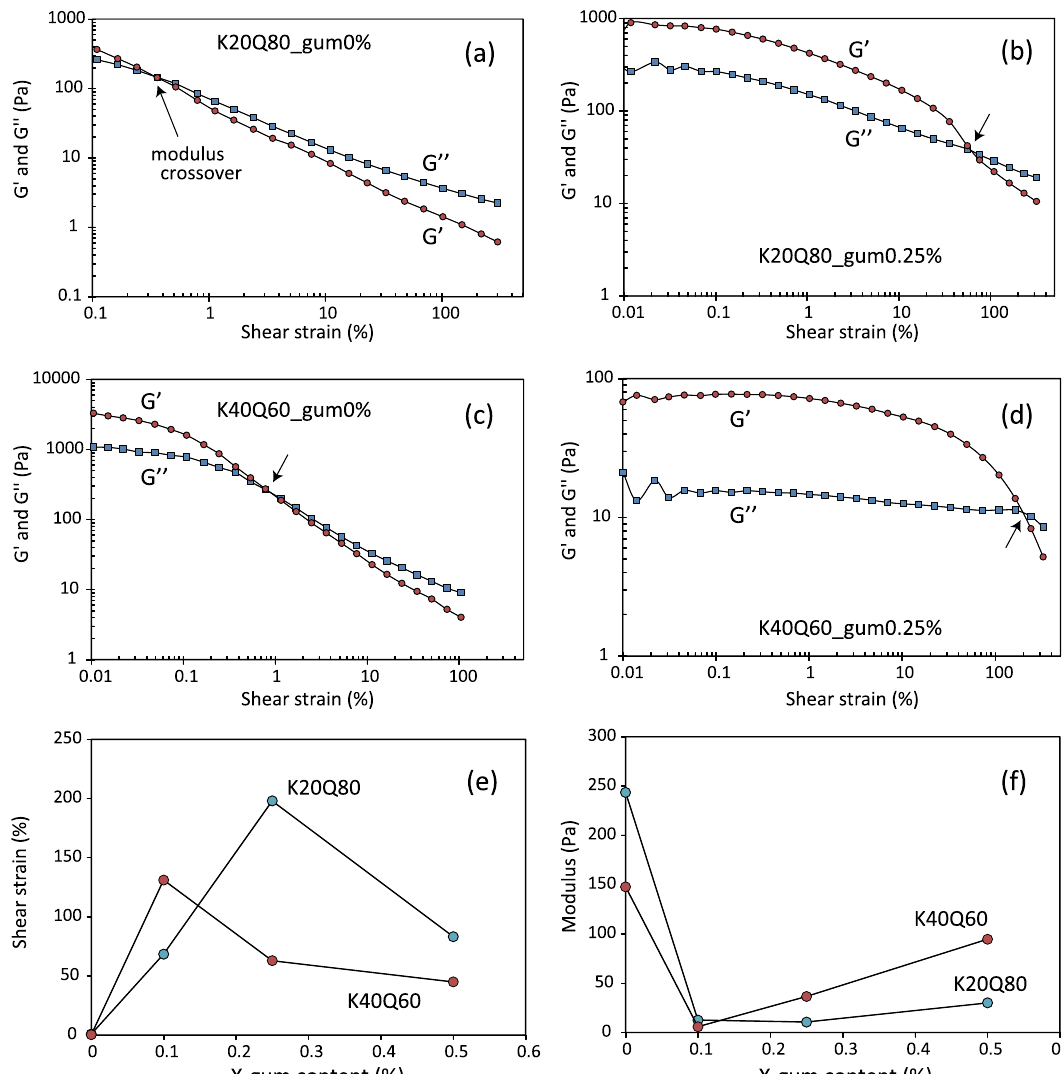
Figure 4. Results of amplitude sweep tests ( a ) K20Q80_0.36 Φ _0% gum, ( b ) K20Q80_0.36 Φ _0.25% gum, ( c ) K40Q60_0.31 Φ _0% gum, and ( d ) K40Q60_0.31 Φ _0.25% gum. G ′ and G ″ are the storage and loss